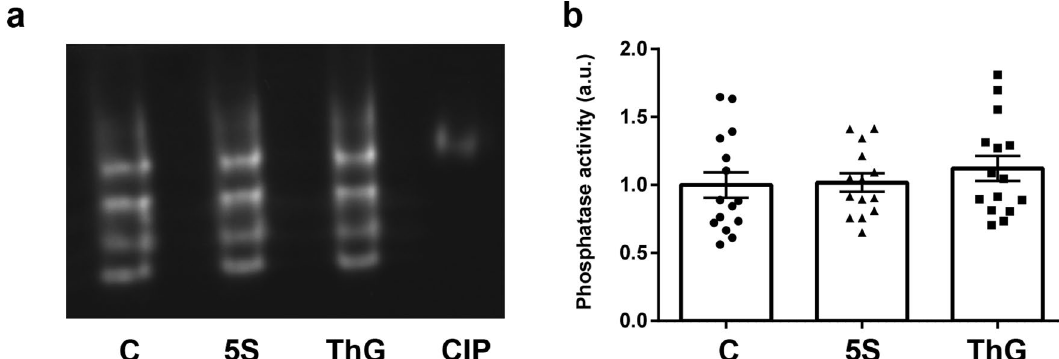
Figure 6. Quantification without an a priori of phosphatase activities involved in the desmin dephosphorylation. ( a ) In-gel detection of phosphatases activity after separation of 75 µg of proteins extracted from untreated myotubes (C, ● ), and Ac 4 -5S-GlcNAc- and Thiamet G-treated myotubes (5S, ▲ and ThG, ■ respectively) using 10% Native-PAGE; MUP was used as phosphatase substrate, leading to fluorescence emission once hydrolysed by phosphatases. The Calf Intestine Phosphatase (CIP, 1 mU) was used as positive control. ( b ) Quantification of total phosphatases activities. Resulting signals were quantified, expressed as mean ± SEM and compared with the control condition (n = 15; N = 3 independent cultures). Uncropped image of gel is presented in Supplemental data.